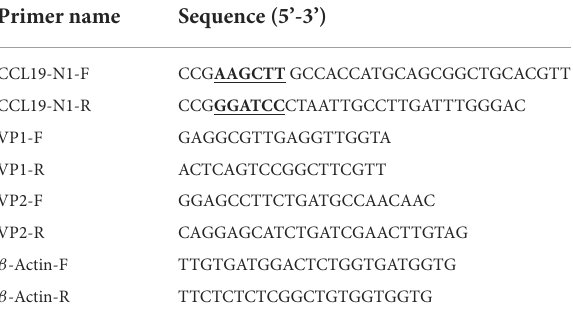
TABLE 1 Primers used for RT-PCR